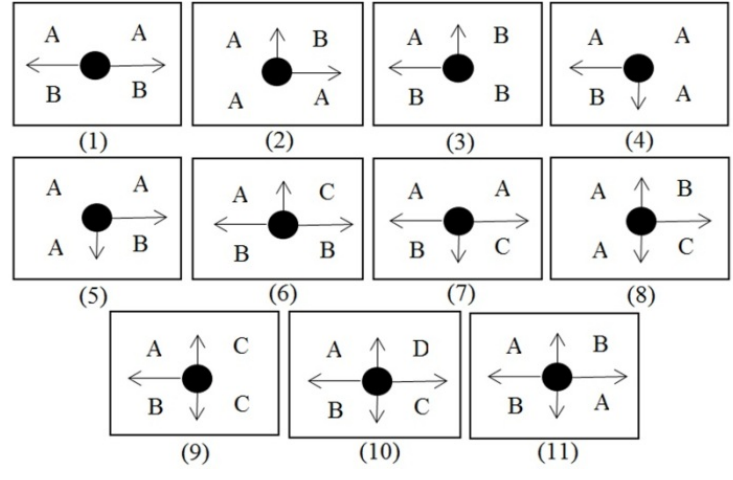
Figure 4. Eleven cases of points [24].